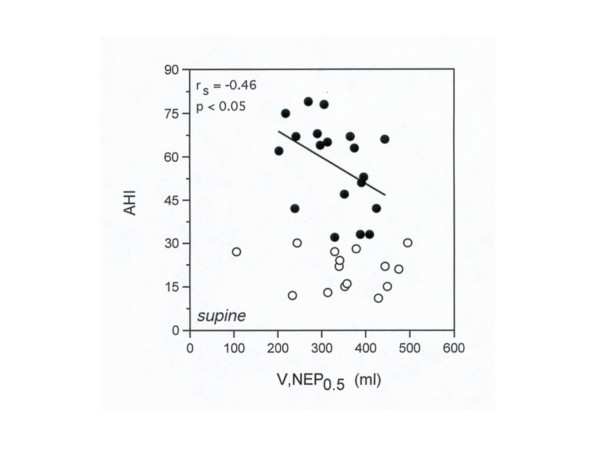
Relationship between AHI and V,NEP0.5 in the supine position during NEP (-5  cmH2O) in OSAH patients (white circles = mild-to-moderate OSAH; black  circles = severe OSAH). The regression line refers only to severe OSAH  patients.